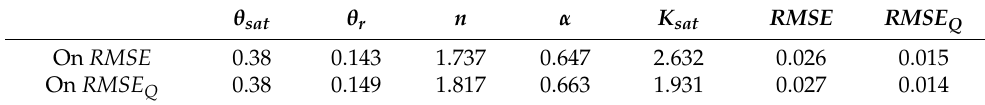
Table 1. Calibration parameter sets. θ sat (m 3 × m − 3 ), θ r (m 3 × m − 3 ), n ( − ), α (m − 1 ), K sat (m × day − 1 ), RMSE & RMSE Q (m 3 × m − 3 ). θ sat θ r n α K sat RMSE RMSE Q On RMSE 0.38 0.143 1.737 0.647 2.632 0.026 0.015 On RMSE Q 0.38 0.149 1.817 0.663 1.931 0.027